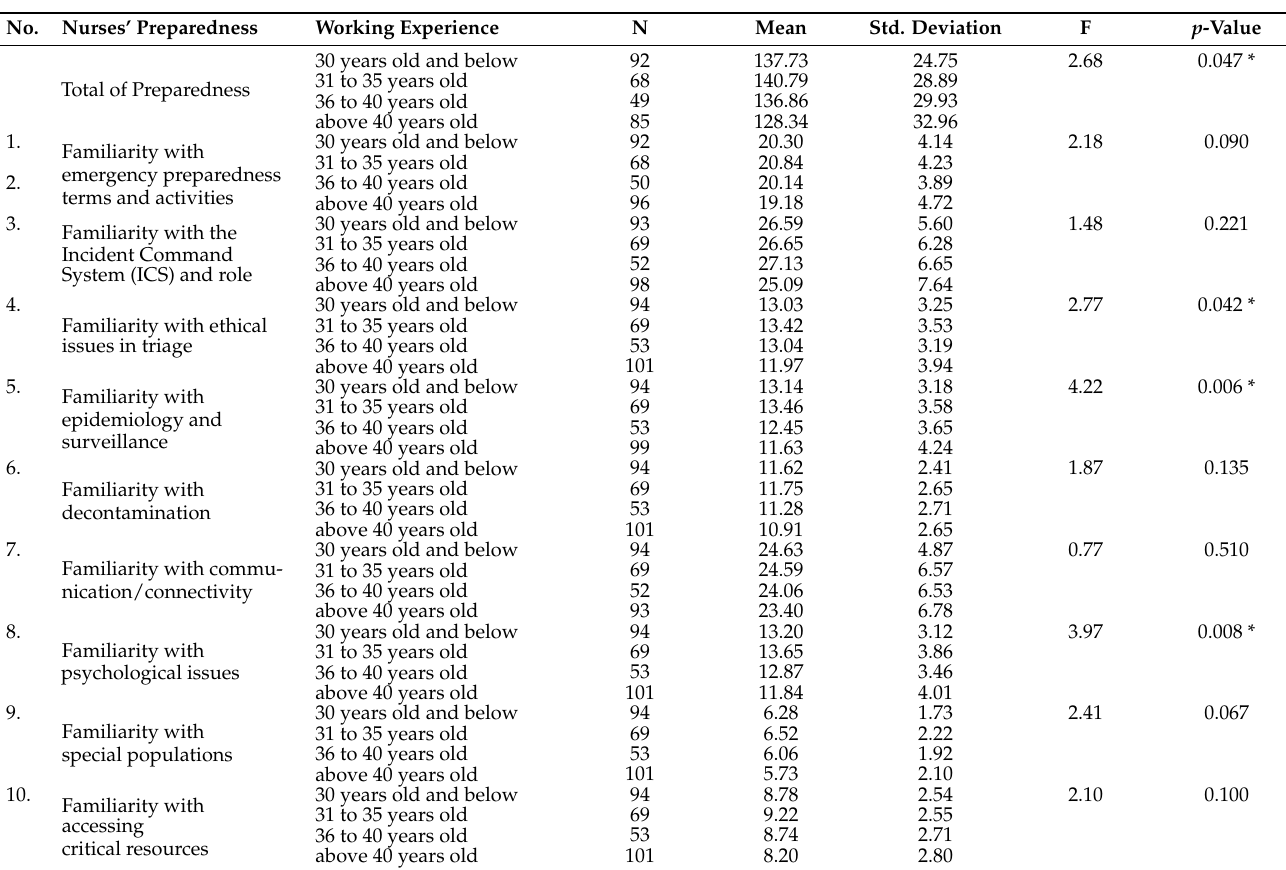
Table 3. Analysis of variance of the nurses’ preparedness in managing COVID-19 pandemic across four categories of